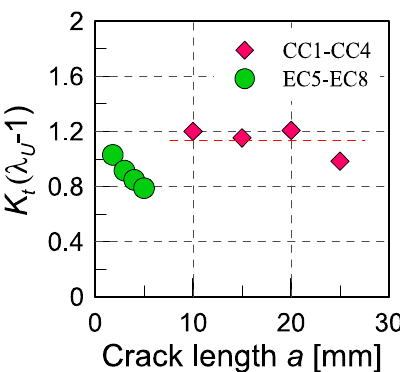
Figure 13. Normalized notch root true stress at incipient failure. The effect of crack blunting is enhanced for the specimens CC1–CC4, with the failure stress being approximately constant (dashed line).